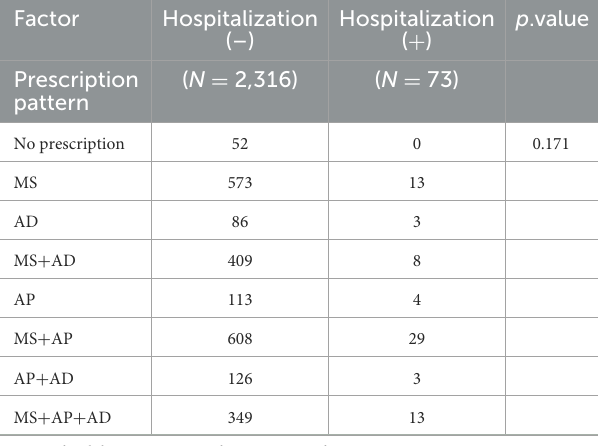
TABLE 2 Prescription pattern among antidepressant, mood stabilizer, and antipsychotic prescriptions. Factor Hospitalization